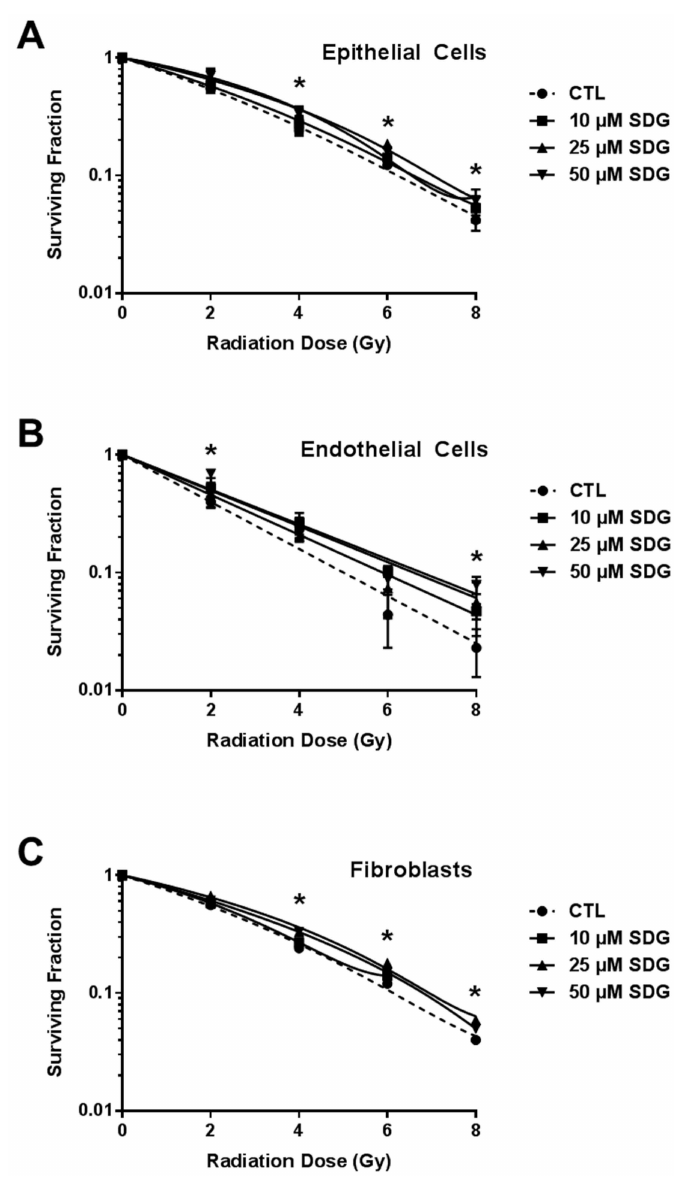
Figure 3. Effect of SDG treatment on radiation dose response of murine lung cells ( A ) Epithelial Cells; ( B ) Endothelial Cells; and ( C ) Fibroblasts. Cells were treated with different concentrations of SDG for six hours prior to gamma irradiation (0, 2, 4, 6, and 8 Gy). All visible colonies were counted two weeks post exposure and surviving fraction was normalized against non-irradiated control values. Data are represented as mean ˘ SEM. * indicates p < 0.05, for irradiated cells vs. SDG pre-treated irradiated